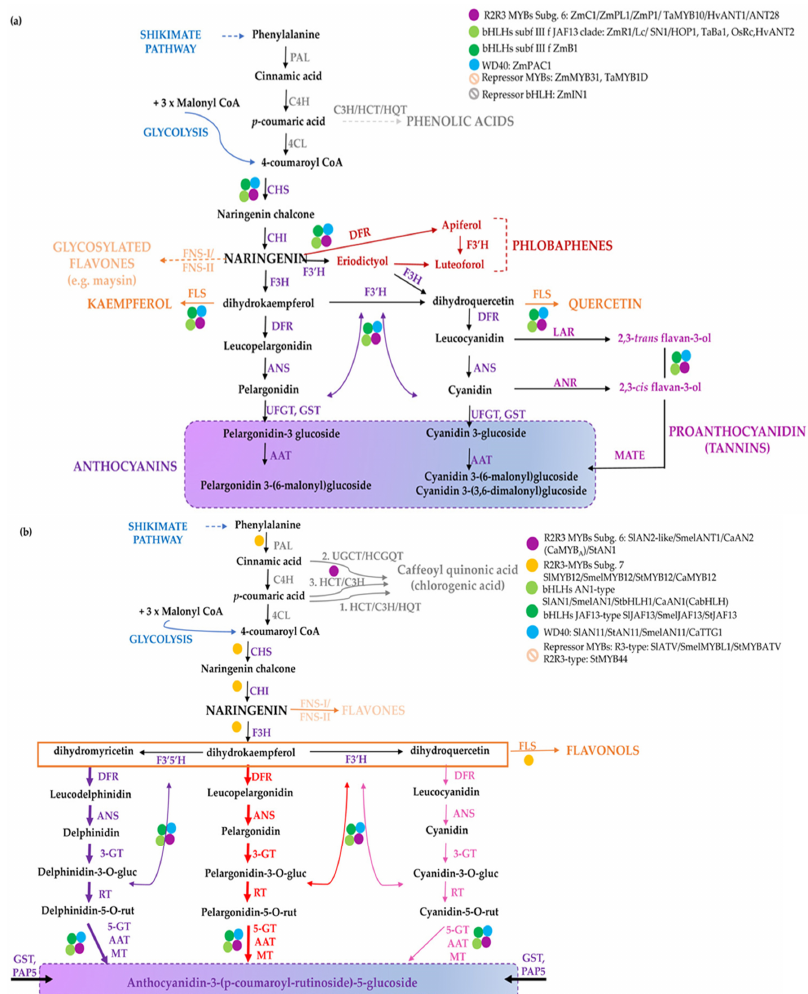
Figure 1. The flavonoid biosynthesis and its regulation in cereal and Solanaceae crops. Scheme of the pathway leading to the production of flavonoids and phenolic acids in monocots ( A ) and dicots ( B ). Phenylalanine is first deaminated by PAL to produce cinnamic acid, then converted by C4H into p- coumaric acid, which can enter the synthesis of hydroxycinnamic acids (i.e., chlorogenic acid and other phenolics) or it can be conjugated with coenzyme A to produce 4-coumaroyl-CoA by 4CL. CHS catalyses the condensation of p-coumaroyl-CoA with three molecules of malonyl-CoA to naringenin chalcone, then converted to the flavanone naringenin by CHI. Indeed, naringenin may be converted to flavones by FNSI/FNSII (e.g., maysin in maize), to the red phlobaphenes, derived from condensation of the 3-deoxy flavonoids apiferol and luteoforol ( A ) and to dihydroflavonols, such as dihydrokaempferol (DHK), which can then be used by F3 ′ H to produce dihydroquercetin (DHQ) or by F3 ′ 5 ′ H to form dihydromyricetin (DHM) ( B ). Dihydroflavonols are then converted to flavonols (e.g., kaempferol, quercetin, and myricetin) by FLS. Downstream, DFR reduces the dihydroflavonols to their respective colourless leucoanthocyanidins, which are then converted into the coloured anthocyanidins (e.g., cyanidin, pelargonidin, and delphinidin). The main enzymes catalyzing the reactions in the pathway are reported in violet. Regulatory proteins belonging to diverse classes of transcription factors are marked with coloured dots. Branches leading to different classes of flavonoids and anthocyanins are indicated with diverse colours; in B, thicker purple and red arrows highlight the branch leading to the most abundant derived anthocyanins. The name of the enzymes is detailed in the abbreviation list.